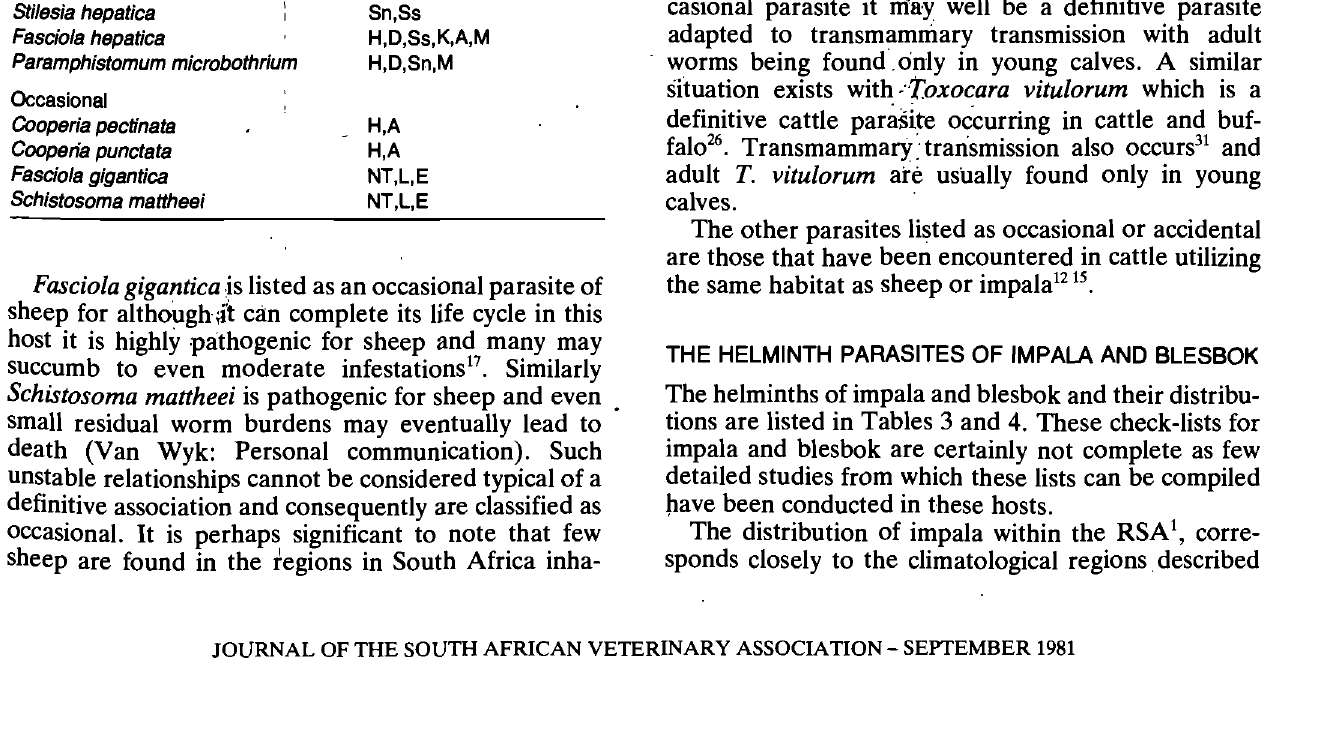
Table 1: DEFINITIVE AND OCCASIONAL HELMINTH PARASITES OF SHEEP AND THEIR DISTRIBUTION IN THE RSA ACCORDING TO CLIMATE. FOR DISTRIBUTION CODE SEE FIG. 1